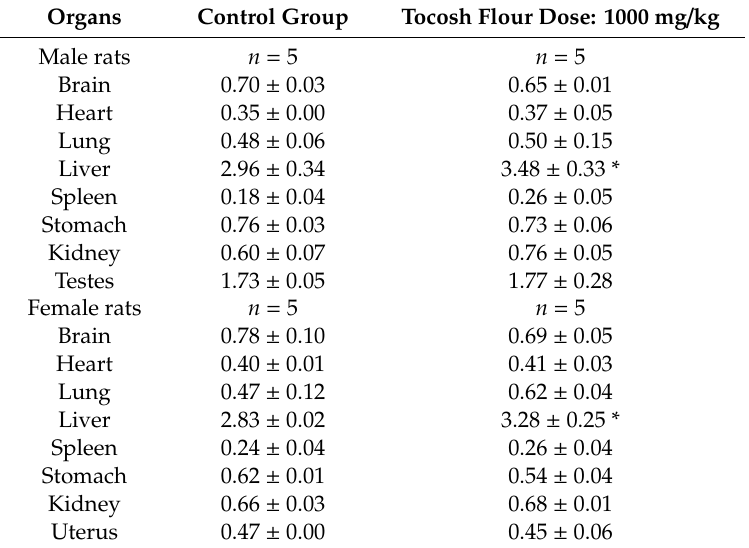
Organs Control Group Tocosh Flour Dose: 1000 mg /